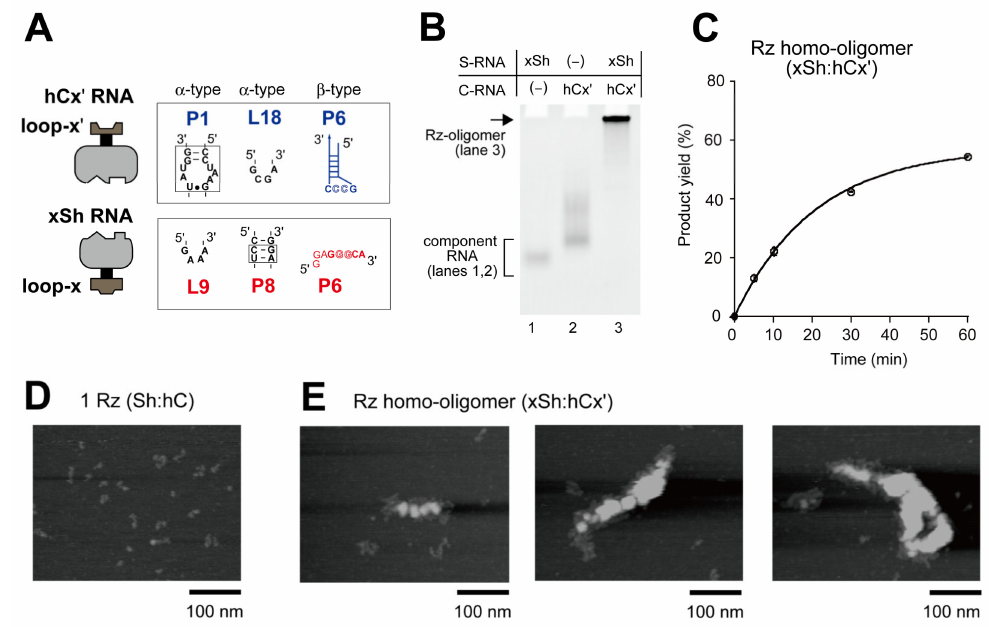
Figure 5. Formation of a ribozyme homo-oligomer. ( A ) Tertiary interactions responsible for the assembly of S-domain and C-domain in a bimolecular ribozyme with the x:x (cid:48) KL motif. ( B ) EMSA of the ribozyme homo-oligomer in the presence of 20 mM Mg 2+ . The concentration of each RNA component was 1.0 µ M. ( C ) Cleavage of pre-tRNA by the ribozyme homo-oligomer in the presence of 20 mM Mg 2+ . The concentration of each RNA component was 1.0 µ M. Some of the error bars are shorter than the size of open circle symbols. ( D , E ) AFM imaging of the bimolecular ribozyme ( D ) and the ribozyme homo-oligomers ( E ) in the presence of 20 mM Mg 2+ . The concentration of each RNA component was 1.0 µ